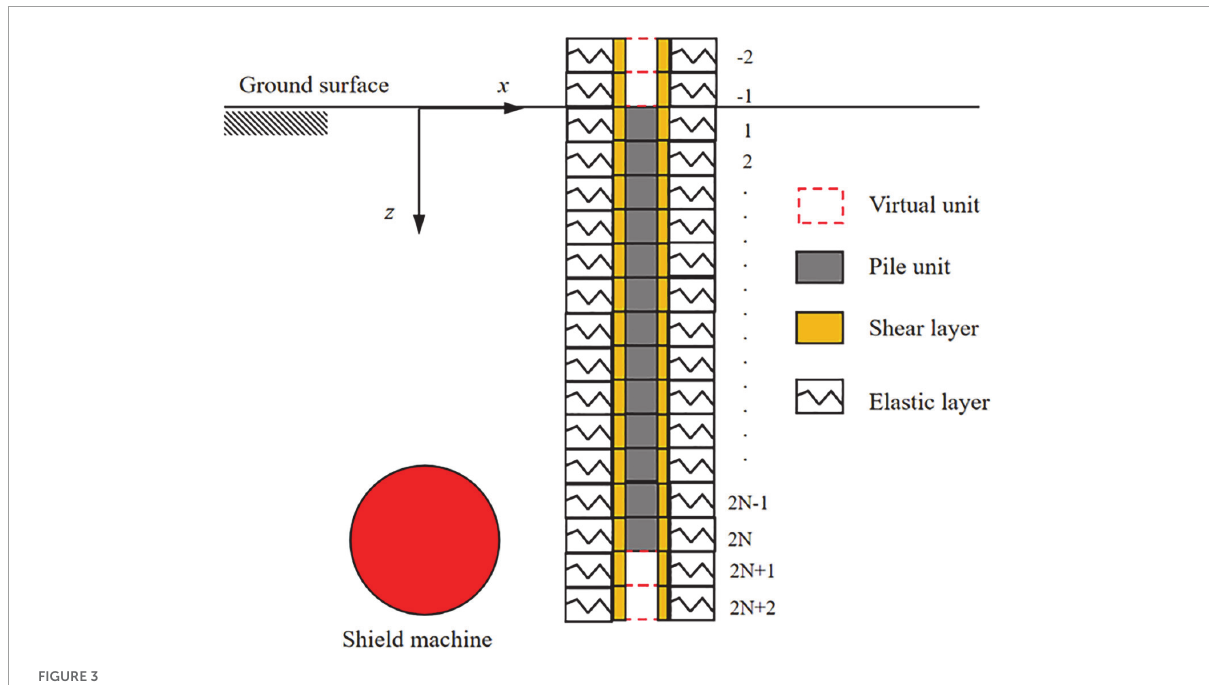
FIGURE3 Pile foundation discrete